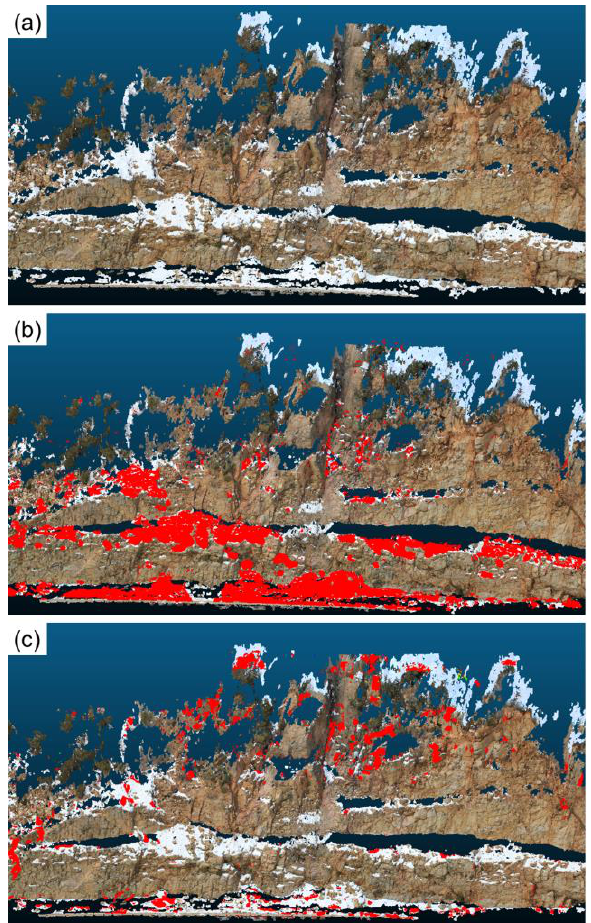
Figure 10. Detected changes (a) TP (2019) dataset shown to highlight the areas of snow; (b) TLS (2018) versus TLS (2019); (c) TLS (2018) versus TP (2019) using the developed algorithm for